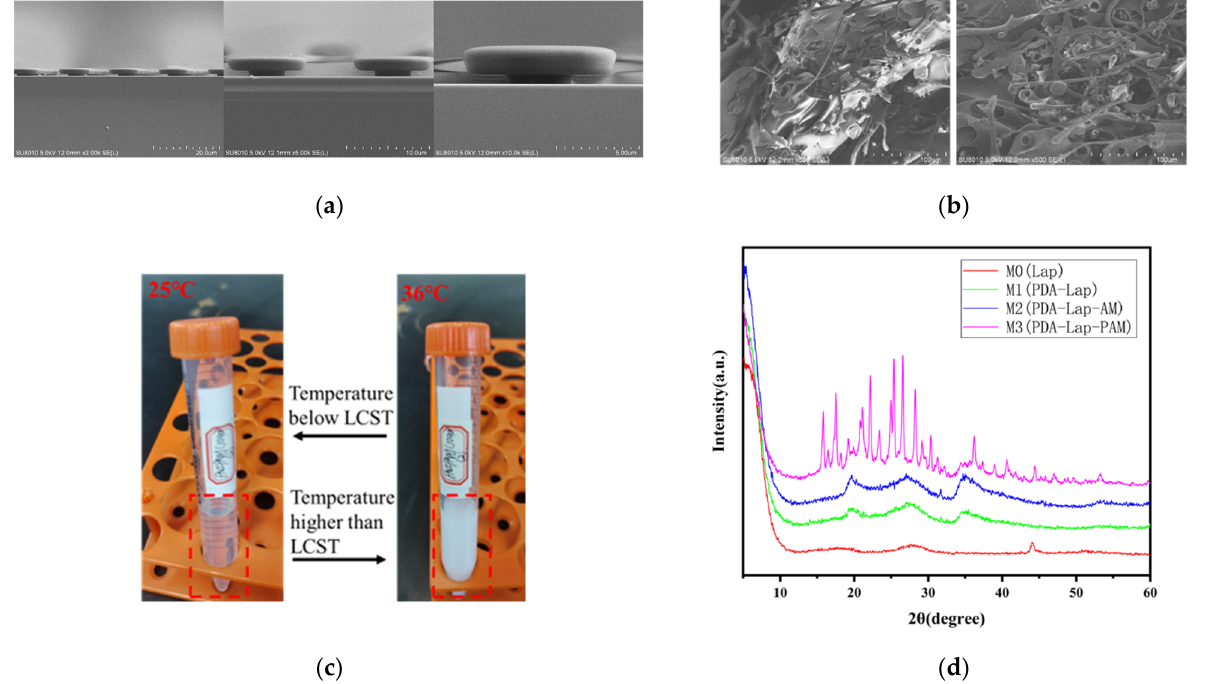
Figure 2. Preparation result characterizations of the two biomimetic structures. ( a ) SEM of the octo- pus sucker structure mold; ( b ) SEM of the thermosensitive hydrogel PNIPAM; ( c ) Color of PNIPAM varying with temperature; ( d ) XRD analysis diagram of the biomimetic mussel mucus hydrogel.